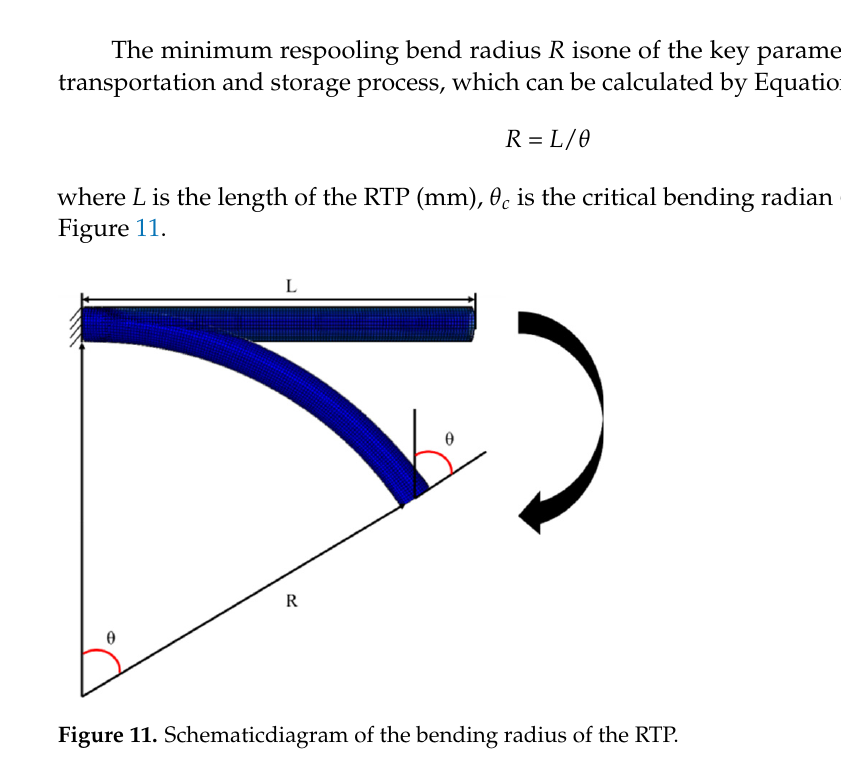
Figure 10. Stress distributions of each layer of the RTP at the bending load: ( a ) the innermost reinforced layer; ( b ) inner liner; ( c ) outer cover.